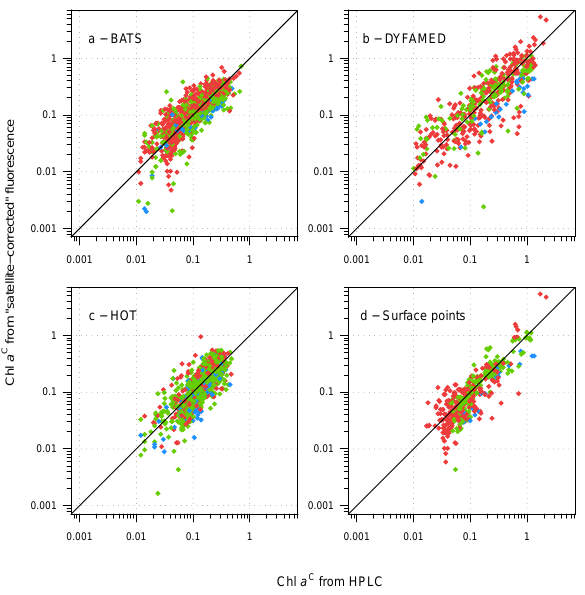
Fig. 1. Scatter plots of “satellite-corrected” Chl a C as a function of concomitant HPLC Chl a C , in mgm − 3 . Colours characterize the er- ror of satellite in the estimation of near surface Chl a C : overestima- tion exceeding 35% (red), underestimation exceeding 35% (blue) and error inferior to ± 35% (green). Only surface points above 20 m depth are displayed in (d) .